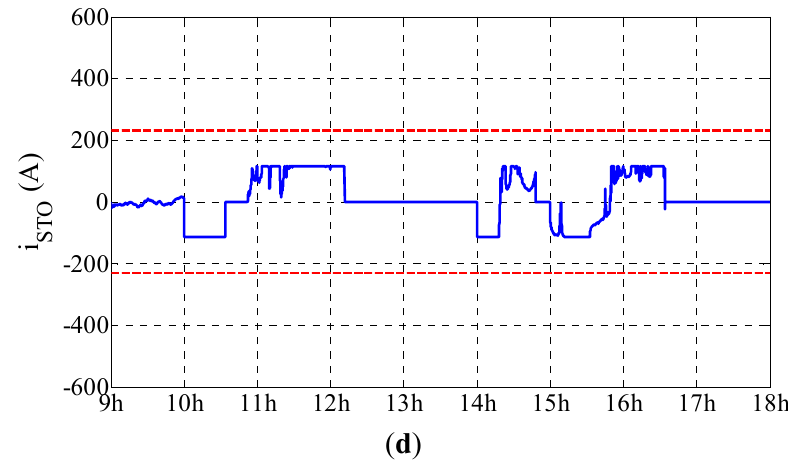
Figure 12. Storage current limitation and public grid power injection limitation case: ( a ) Power evolutions of PVA, PEVs, and the difference between these two powers; ( b ) Storage SOC and distribution coefficient K ; ( c ) Power evolutions of storage and public grid; ( d ) Storage current